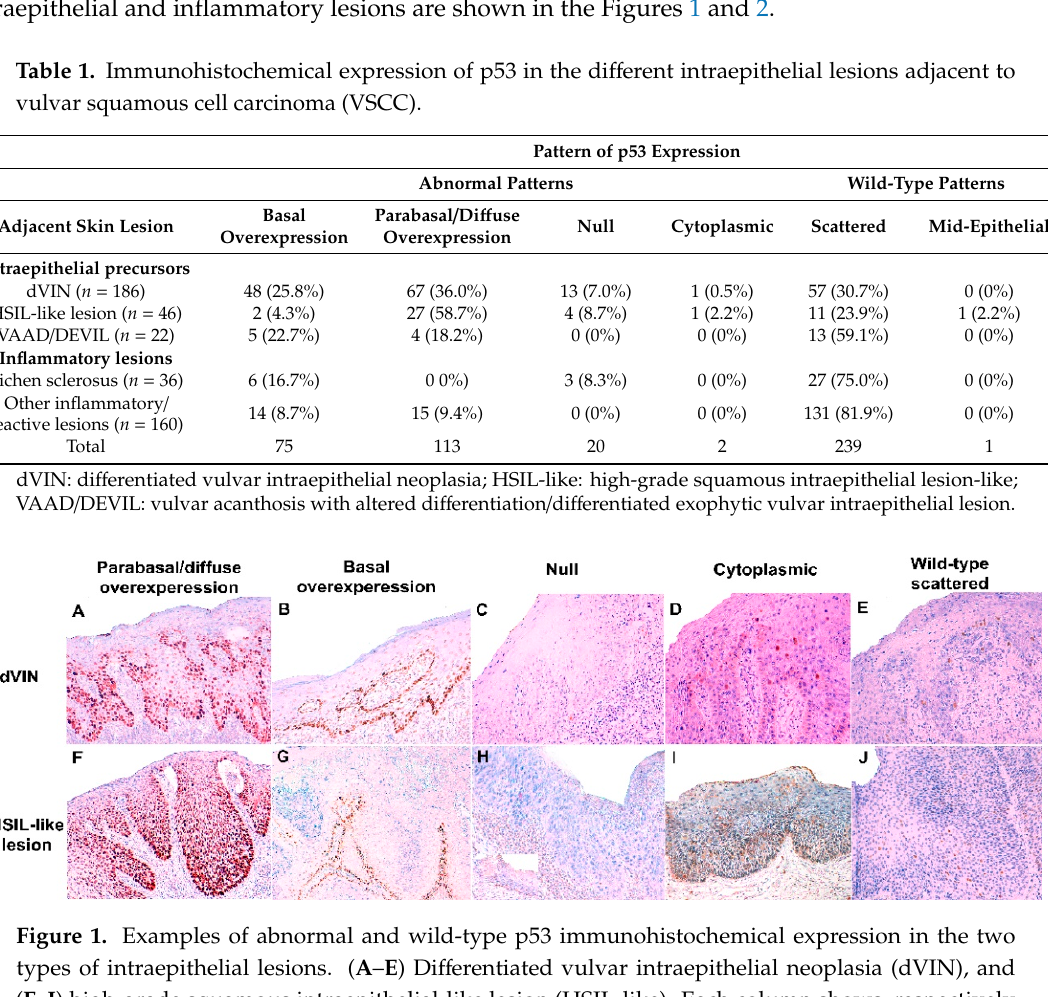
Figure 2. Examples of abnormal and wild-type p53 immunohistochemical expression in vulvar acanthosis with altered differentiation (VAAD), lichen sclerosus (LS) and inflammatory/reactive lesions. ( A , G ) Parabasal/diffuse patterns; ( B , D , H ) basal pattern; ( E ) null pattern (with wild-type staining in the hair follicle on the left); ( C , F , I ) wild-type scattered staining. (p53 IHC immunostaining with hematoxylin counterstain, original magnification: 100×). Table 2 shows correlation of the p53 IHC patterns between invasive VSCC and their respective adjacent skin lesions in 450 VSCC. Two hundred and ten out of 450 VSCC (46.6%) had abnormal p53 staining both in the adjacent skin lesion and in the invasive component. The type of an abnormal p53 IHC pattern in the invasive VSCC and in the skin lesion was identical in 80% of the cases (168/210). Discrepancies in the abnormal p53 IHC pattern were only observed between basal and parabasal/diffuse overexpression, whereas all invasive VSCC with null or cytoplasmic abnormal patterns had the same pattern in the surrounding skin lesion. One hundred and forty-four VSCC out